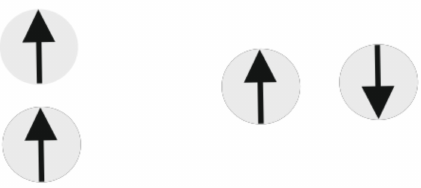
Figure 2. Illustration of the “head-to-tail” (left) and “side-by-side” (right) relative alignments of the particles.